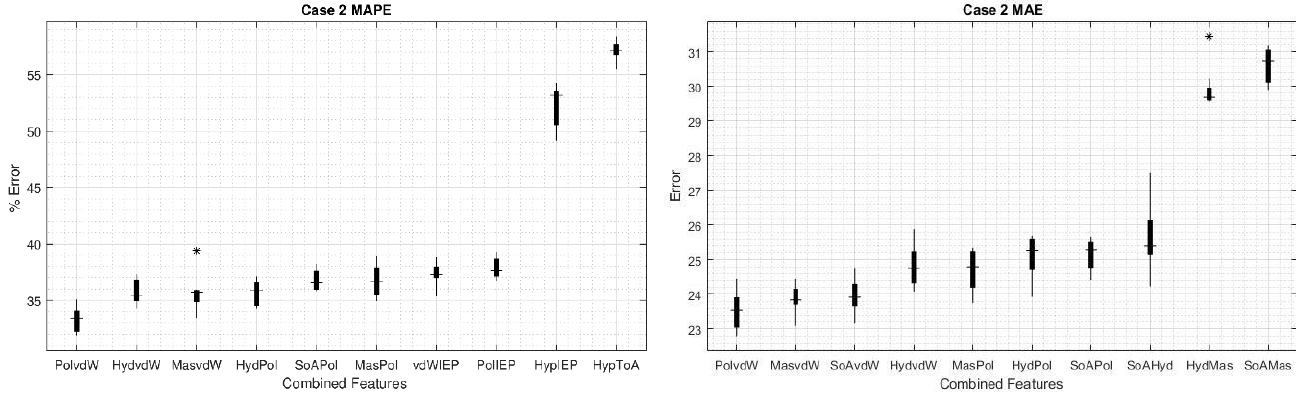
Figure 5. Box plots of the results for case 2. Values obtained for MAPE ( left ) and for MAE ( right ). The first eight combinations with the lowest errors are shown, as well as the two combinations with the highest errors. The * sign denotes outliers.